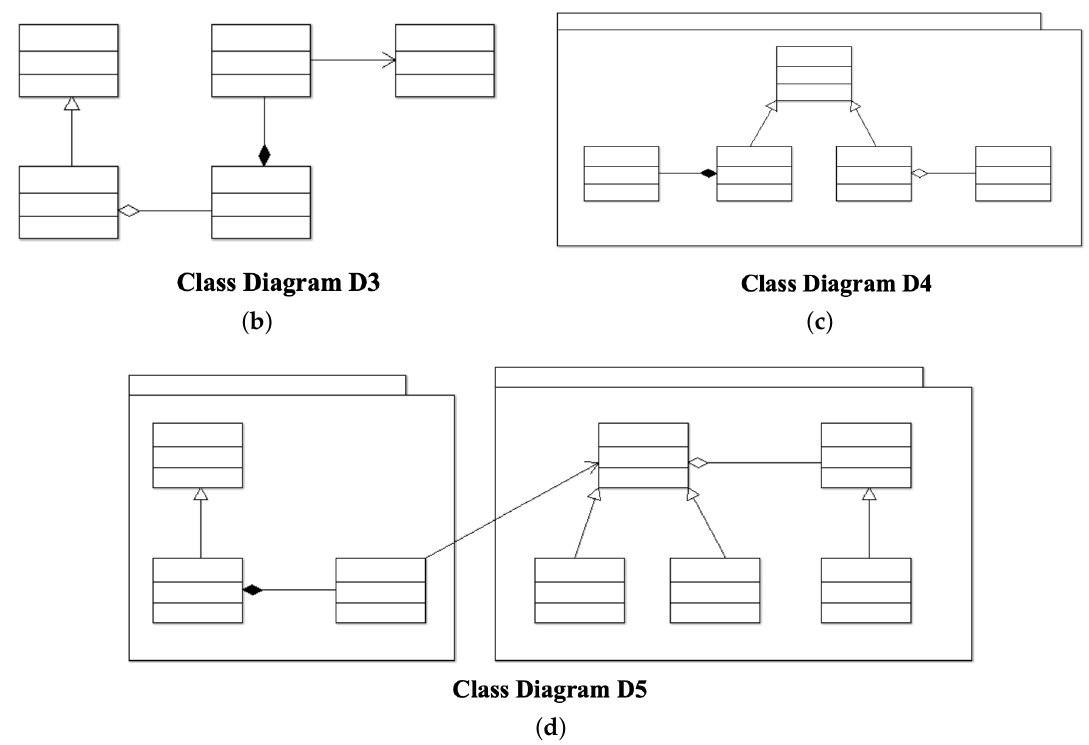
Figure A1. The five class diagrams to be drawn in an unconstrained fashion by the twenty subjects using SketchBench